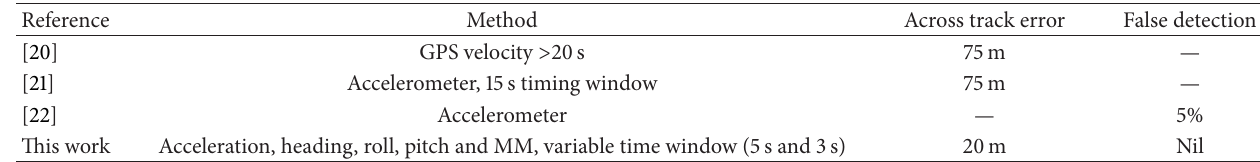
Table 3: Comparison of accuracy of the proposed method with other reported